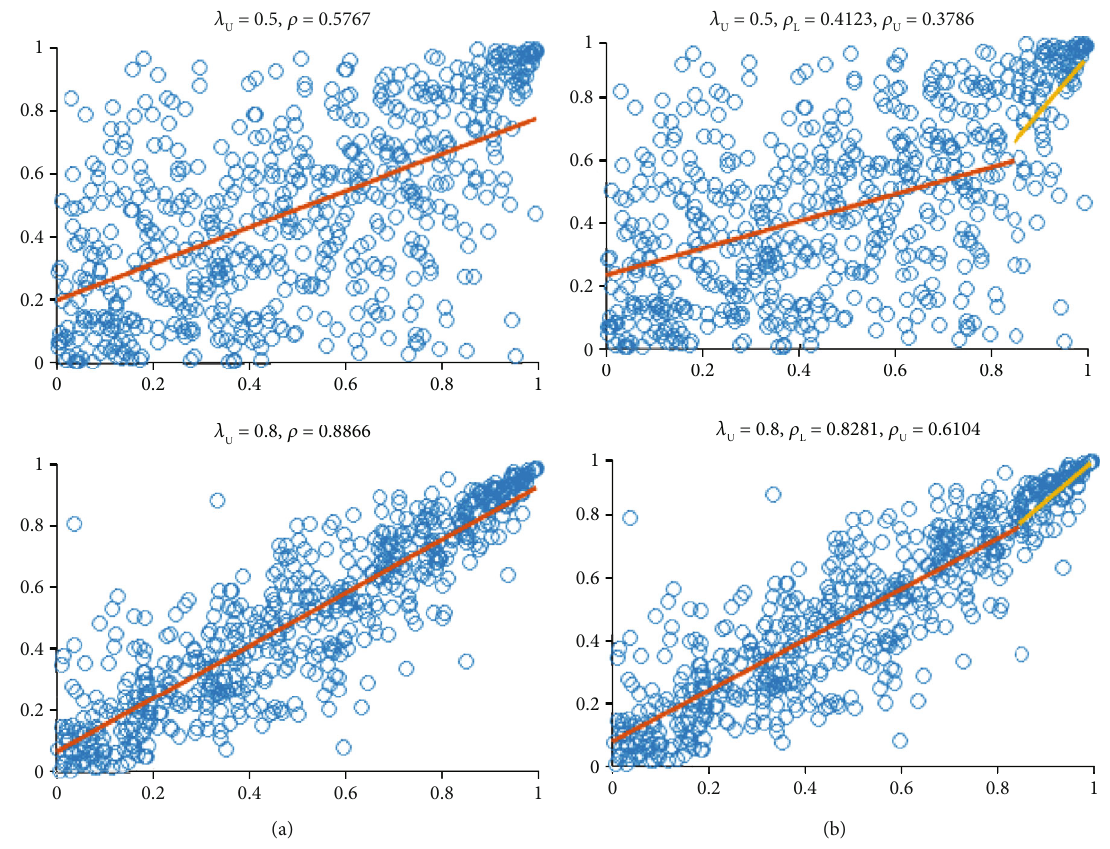
Figure 11: Correlation line(s) for the Gumbel copula generated data with upper tail dependence coe ffi cient; (b) shows two correlation coe ffi cients, upper and lower, to cover dependence behavior of the whole Table 5: Correlation, rank, and upper tail dependence-based estimative VaR forecast for a single random loss and a random loss that depends on another random loss.